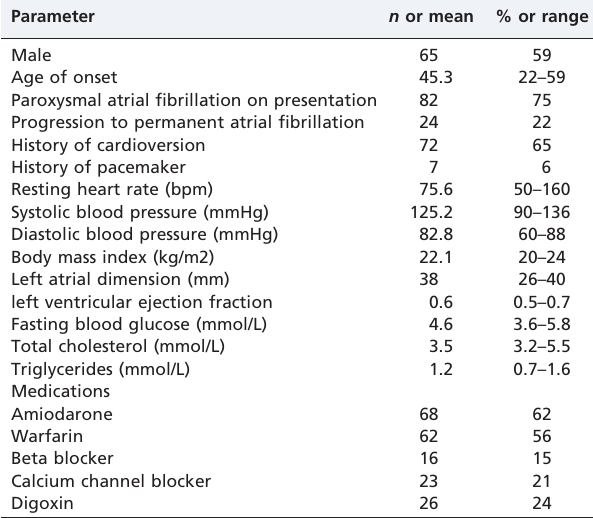
Table 1 - Baseline clinical characteristics of the 110 probands with familial atrial